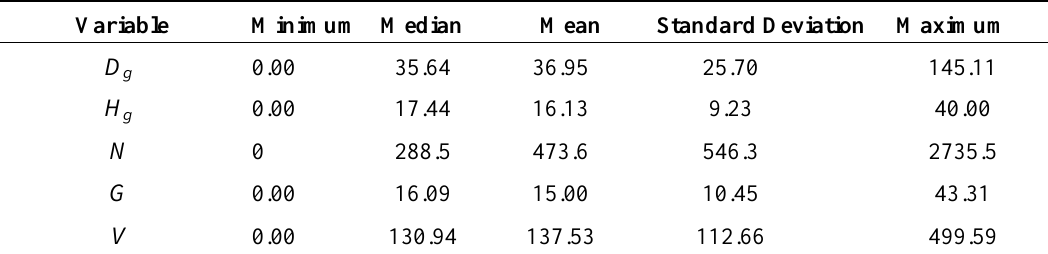
Table 2. Descriptive statistics for the CCSP data, ( n = 217): D mean diameter at breast height (cm), H the number of living trees (ha −1 ), G is the stand basal area of living trees (m 2 ∙ha −1 ) and V is the stand volume of living trees (m 3 ∙ha −1